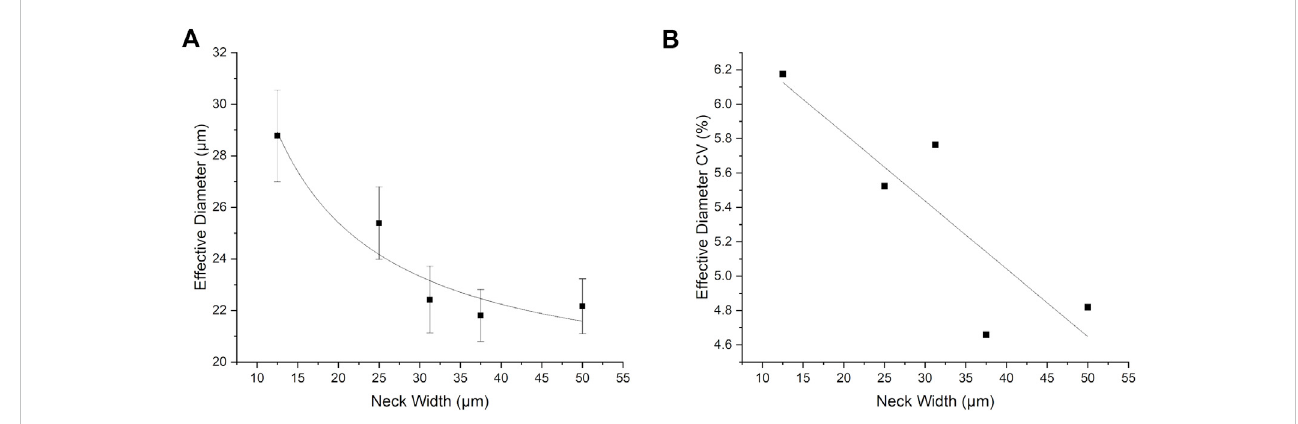
FIGURE 9 (A) Effective droplet diameter and (B) diameter CV plotted as a function of neck